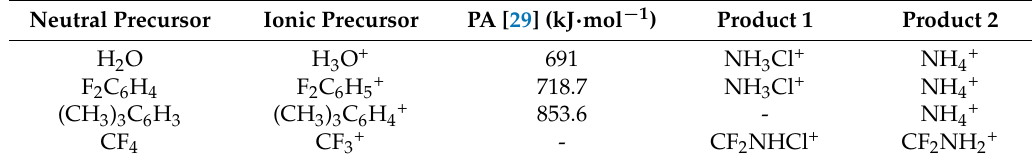
Table 1. Products observed by ion-molecule reaction of the permeate of a monochloramine solution and 4 precursors. 3 of them are proton transfer